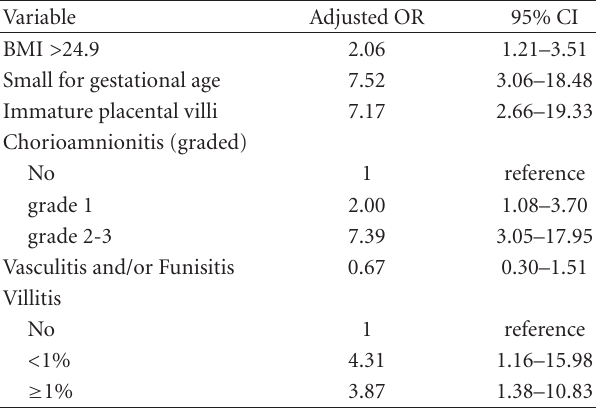
Table 3: The adjusted odds ratio and their 95% confidence intervals for maternal and childe demographic data and histopathological findings in placentas from stillborns and liveborn